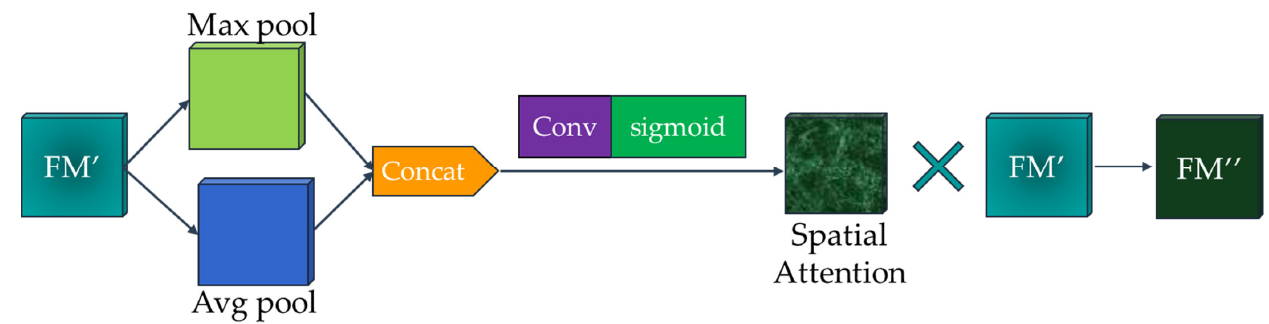
Figure 4. Spatial attention module process.